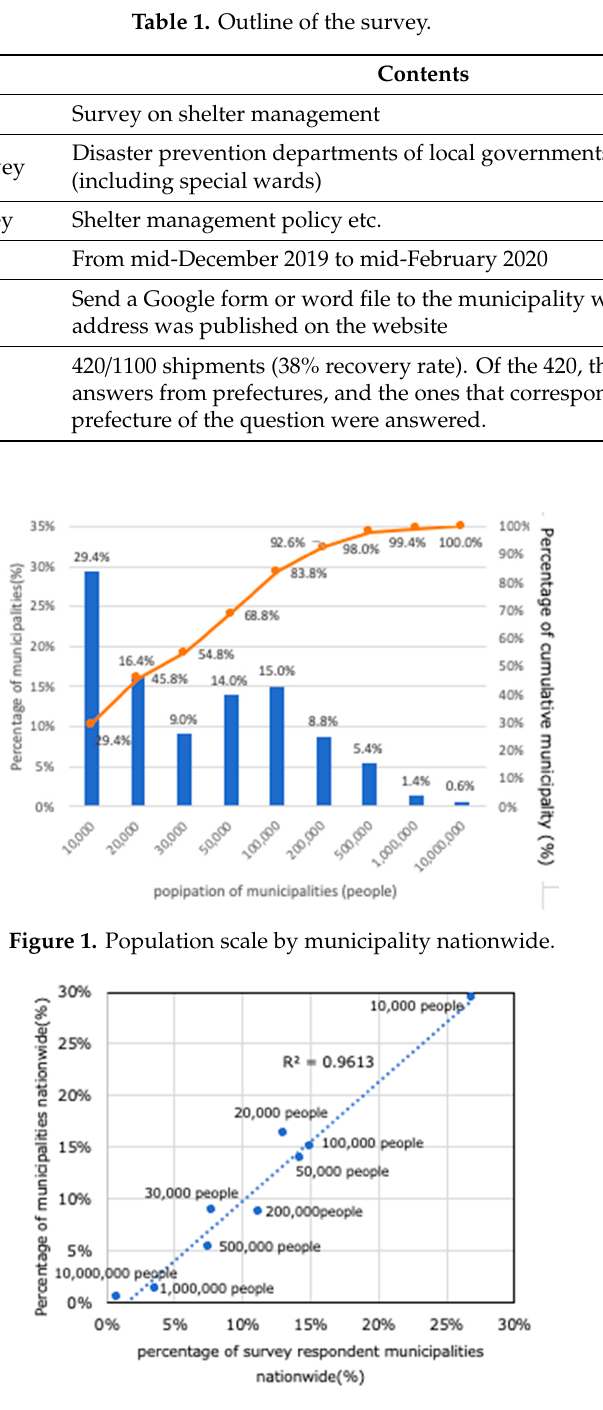
Figure 2. Population size by municipality and percentage of survey respondent municipalities nationwide.